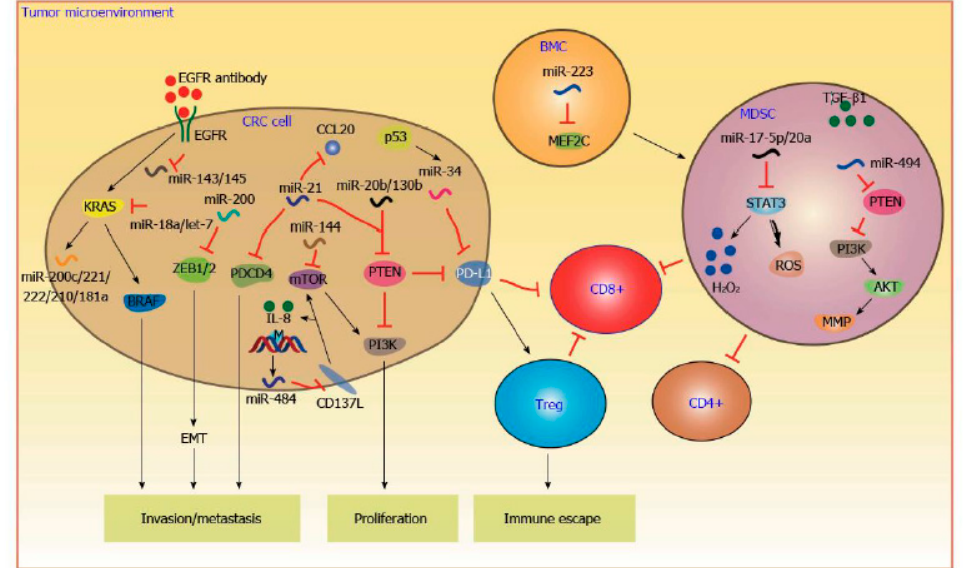
Figure 3. MicroRNAs control colorectal carcinoma progression through modulating anti-tumor immune responses in the tumor microenvironment. For example, miR-20b and miR-130b repress the expression of Phosphatase and tensin homolog (PTEN) and increase the activity of Phosphoinositide 3-kinase (PI3K), leading to the increased viability of CRC cells. MiR-21 promotes CRC invasion and metastasis by directly targeting Programmed Cell Death 4 (PDCD4). Furthermore, miR-34a enhances cluster of differentiation 8 (CD8+) T cells cytotoxicity by repressing the expression of programmed death-ligand 1 (PD-L1), contributing to the elimination of CRC cells by cytotoxic T lymphocytes (CTLs). Reproduced with permission from [68].